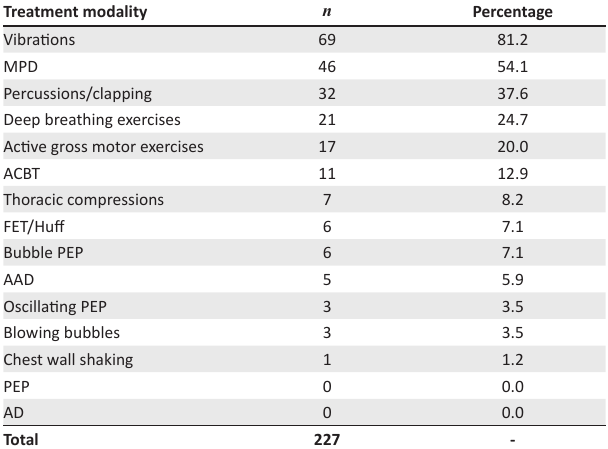
receiving airway clearance therapies (multiple airway clearance therapies could be used per